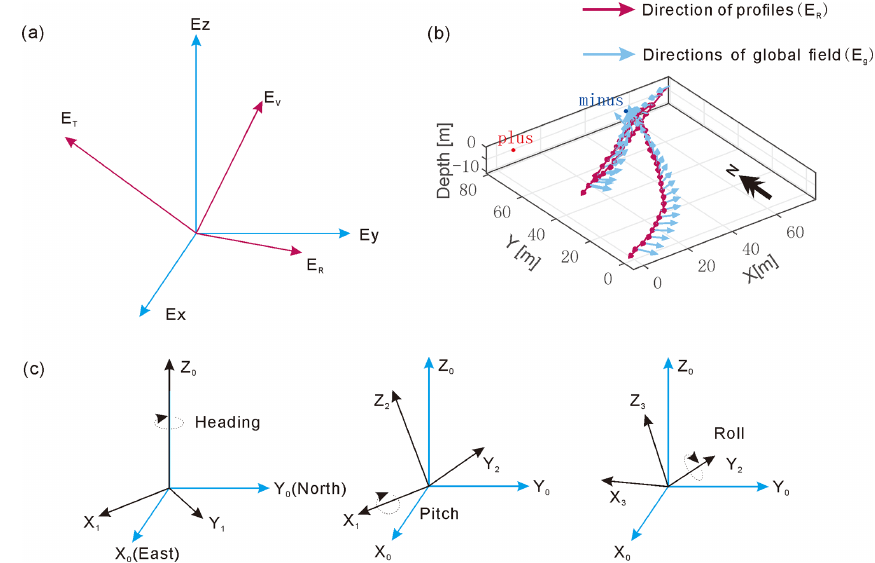
Figure 5. Rotation relationship between the global electrical field E g and rotated electrical field E rot . (a) The projection of the global and rotated electrical fields in a Cartesian coordinate system. (b) The path of the AUV in the water; arrows denote the direction of AUV movement and the vector direction of the total electrical field in a geodetic coordinate system. Plus signs denote the position of positive pole, and minus signs denote the position of negative pole. (c) Definition of the different attitude angles.